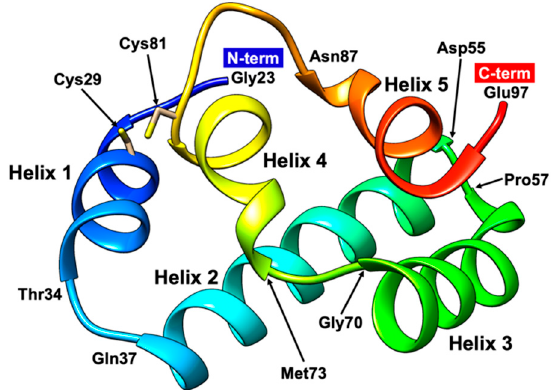
Figure 5. 1.60 Å crystal structure of gp61.3. Molecule is colored in rainbow from blue (N-term) to red (C-term). The start and end residues for each helix are indicated.